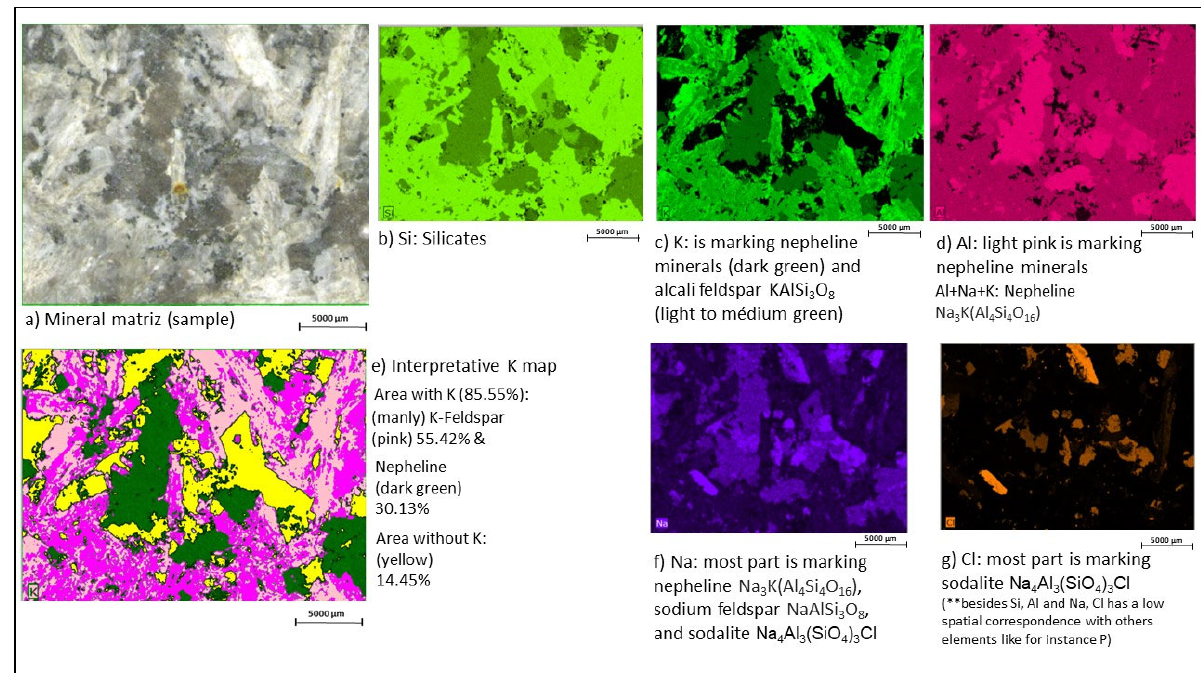
Figure 2. Original mineral sample, µ -EDXRF and interpretative maps: ( a ) Image of mineral matrix (sample), ( b ) Si µ -EDXRF map; ( c ) K µ -EDXRF map, ( d ) Al µ -EDXRF map, ( e ) interpretative K map,